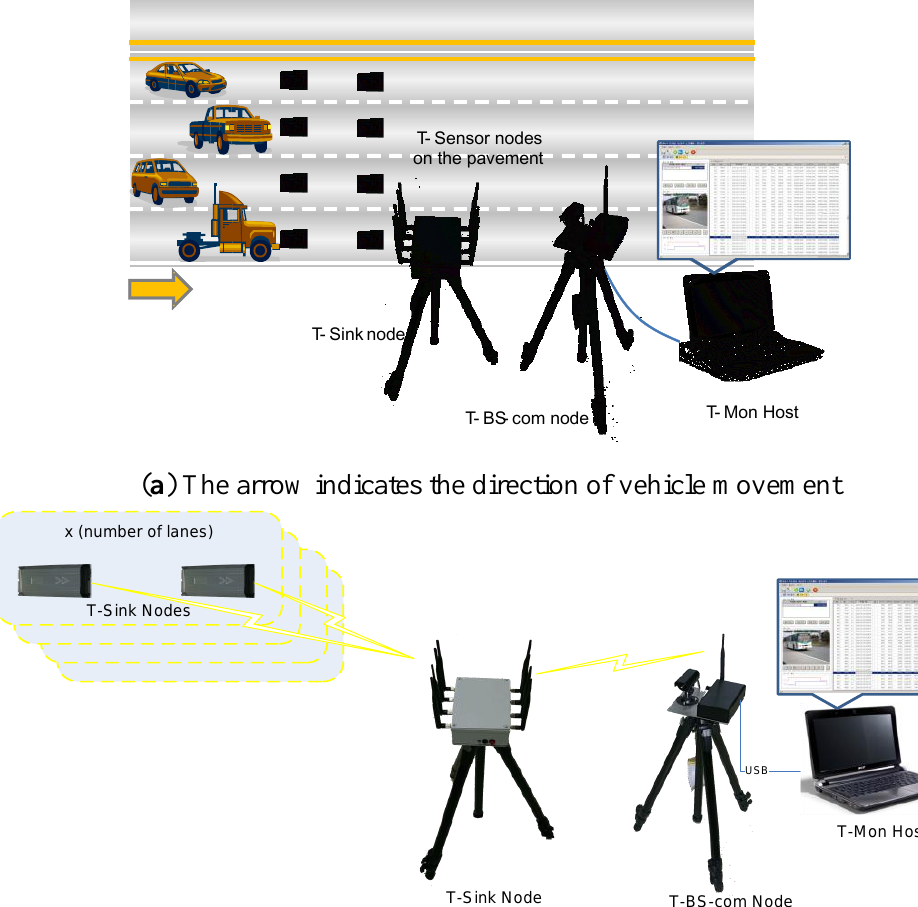
Figure 1. ( a ) Overall system description ( b ) System description with network connections.